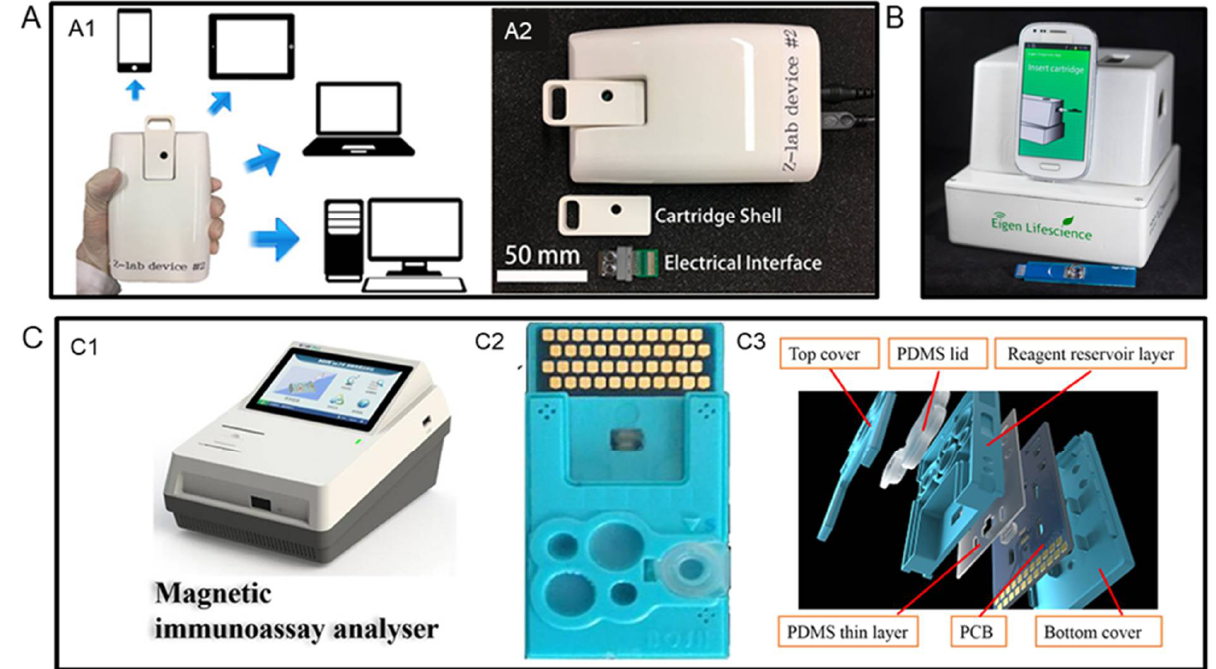
Figure 5. ( A , A1 ) Z-lab can communicate with smartphones, tablets, laptops, and desktop computers. ( A2 )Photograph of the Z-lab diagnosis platform.( B ) Photograph of the Eigen Diagnosis Platform. ( C , C1 ) Photographs of the point-of-care GMR biosensing platform reported by Gao et al. ( C2 ) Photograph of the test card. ( C3 ) The structure of the test card. ( A ) is reprinted with permission from Ref. [96], Copyright 2017, American Chemical Society. ( B ) is reprinted with permission from Ref. [95], Copyright 2016, Elsevier B.V. ( C ) is reprinted with permission from Ref. [23], Copyright 2018, Elsevier B.V.